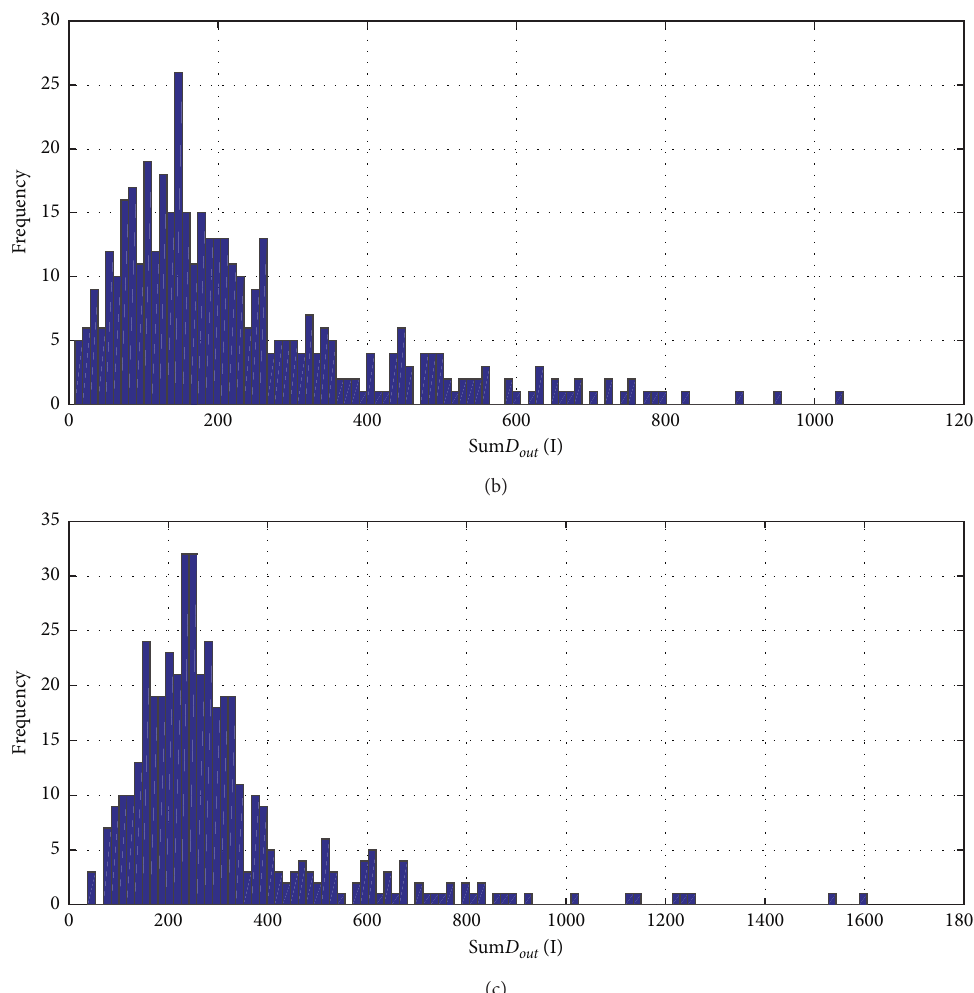
Figure 13: Distributions of Sum D ( i ) for different time periods: (a) morning peak time; (b) nonpeak time; (c) evening peak time. out